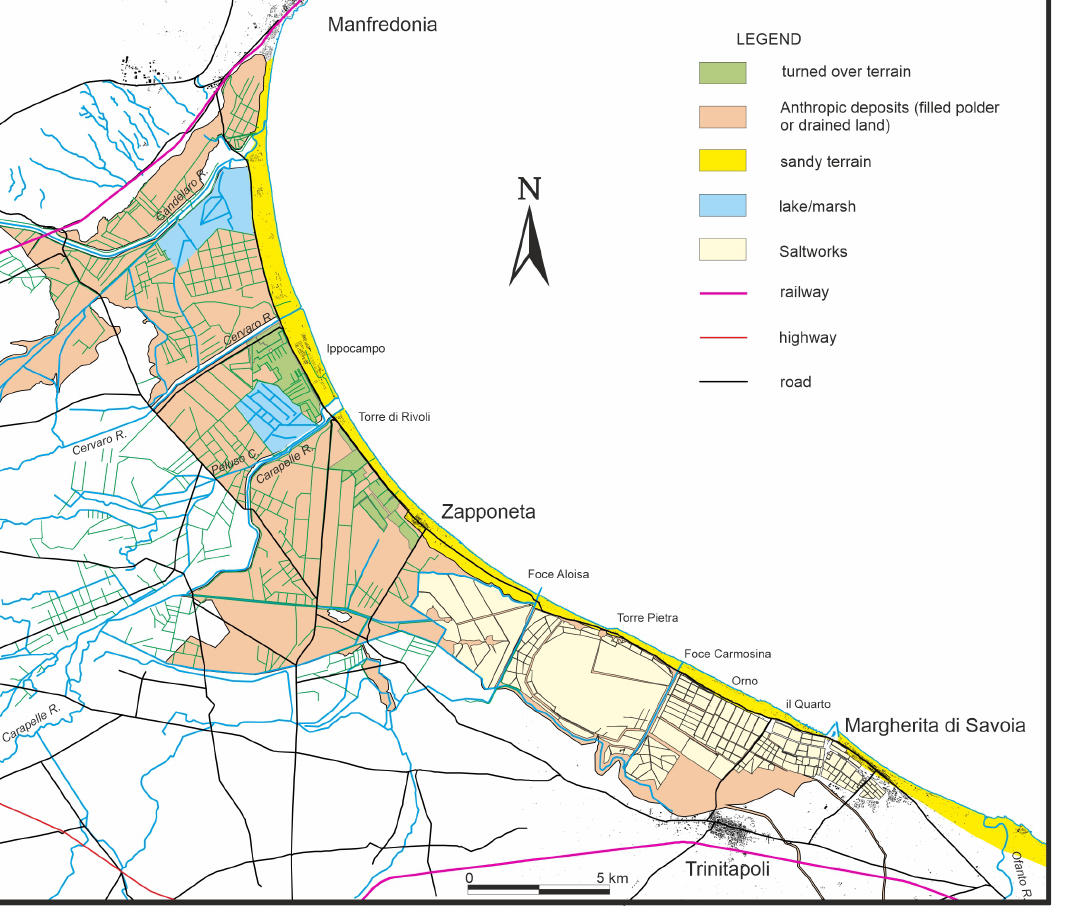
Figure 11. Coastal areas affected by the agricultural practice of “turning”.